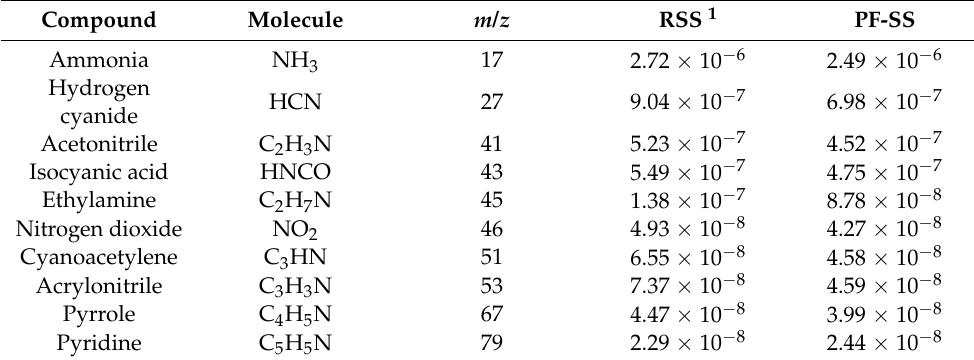
Table 3. Peak integrated areas of gas products containing N pollutants.